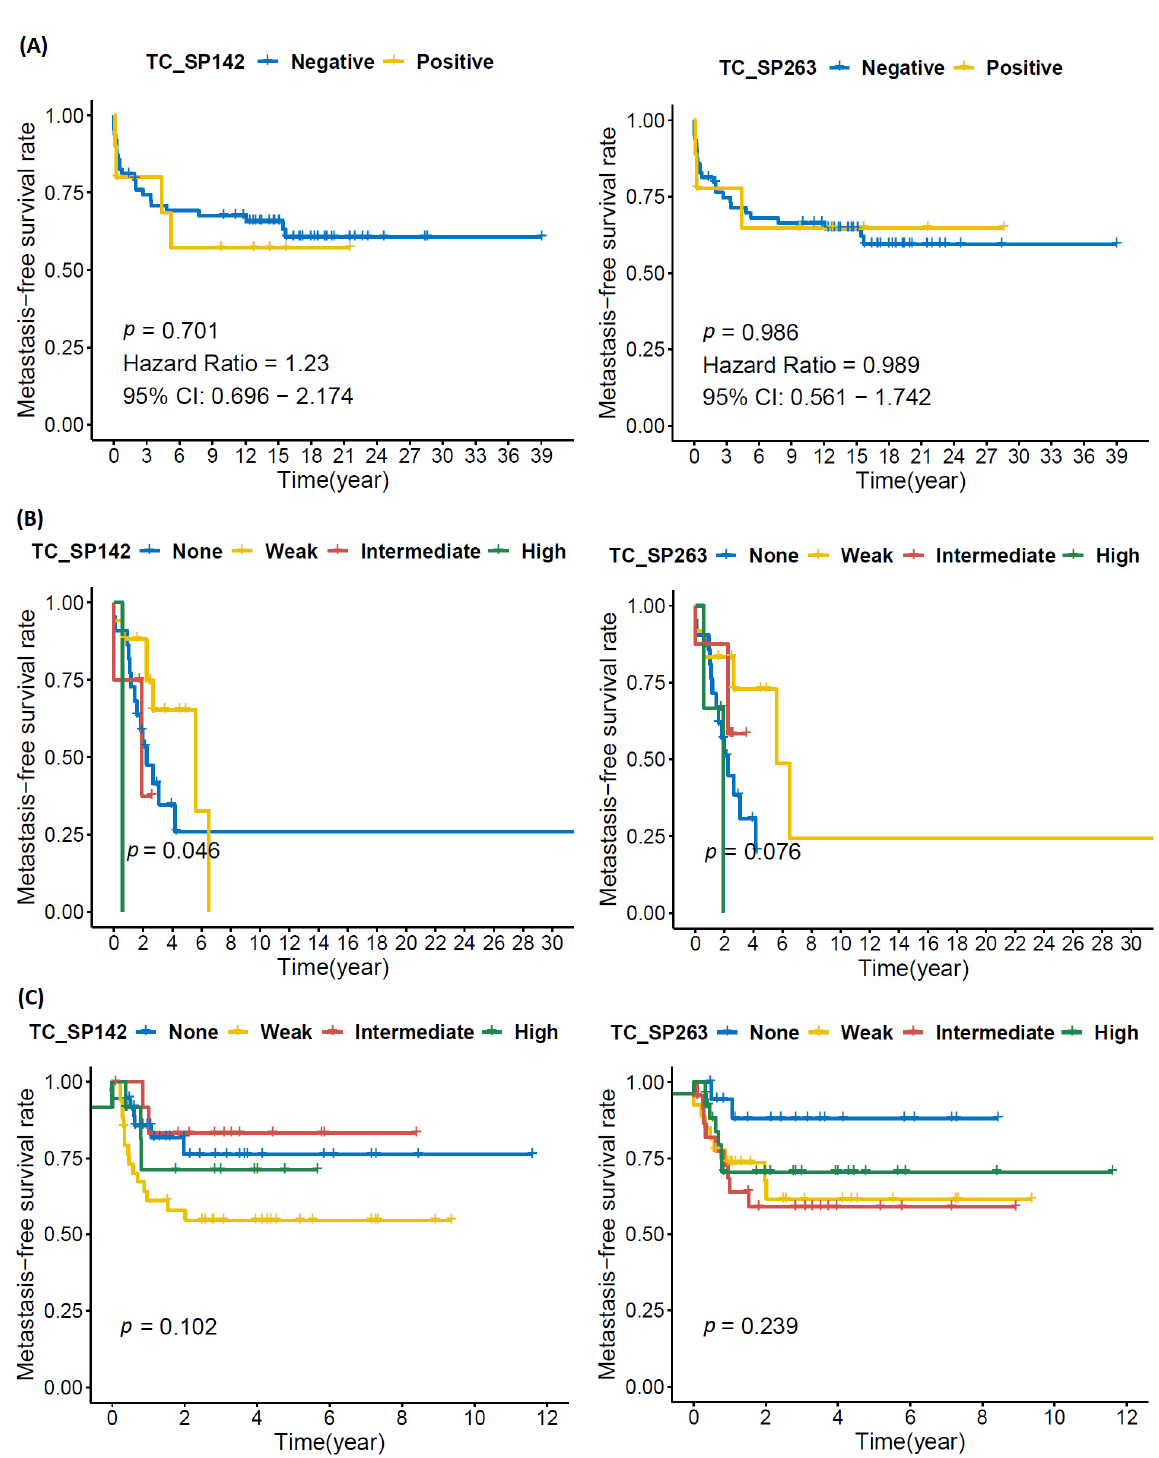
Figure A3. Kaplan–Meier curves depicting MFS based on PD-L1 immunoreactivity in tumor cells for ( A ) chondrosarcoma, ( B ) liposarcoma and ( C ) undifferentiated pleomorphic sarcoma.